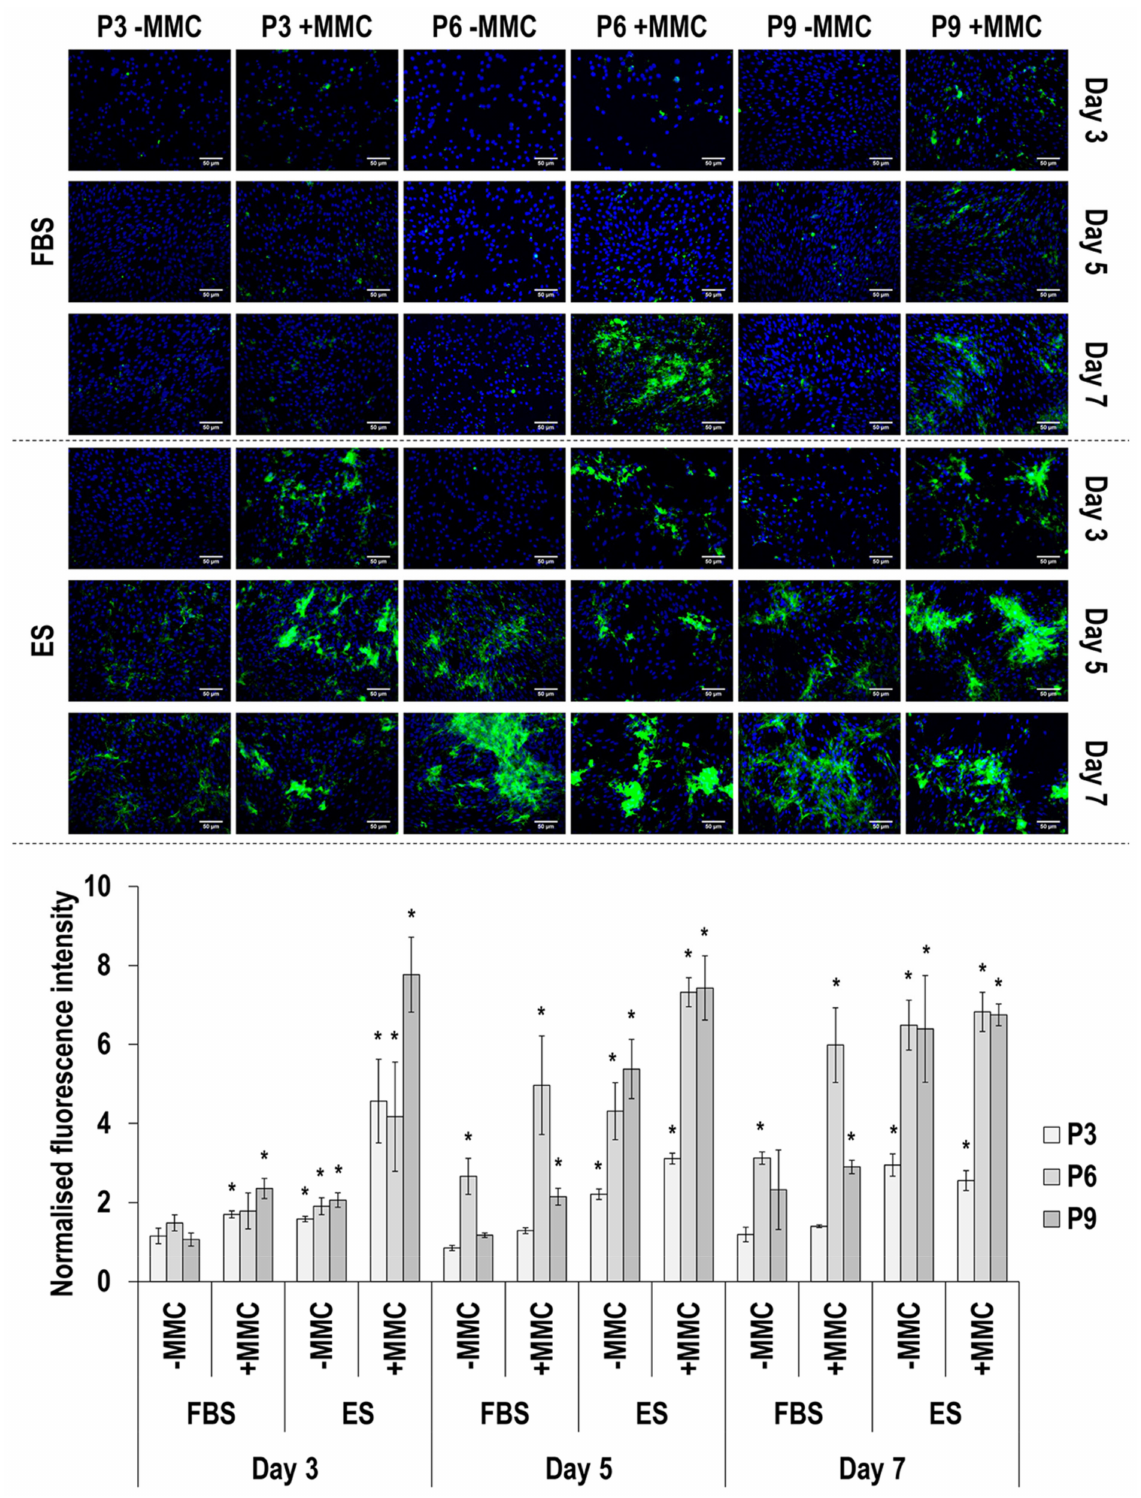
Figure 3. Immunofluorescence and image intensity analysis for collagen type III as a function of serum, passage, MMC and time in culture. Fluorescence intensity was normalised to cell number. * indicates a significant ( p < 0.05) increase in comparison to cells at passage 3, day 3, in FBS and without MMC. Scale bar: 50 µ